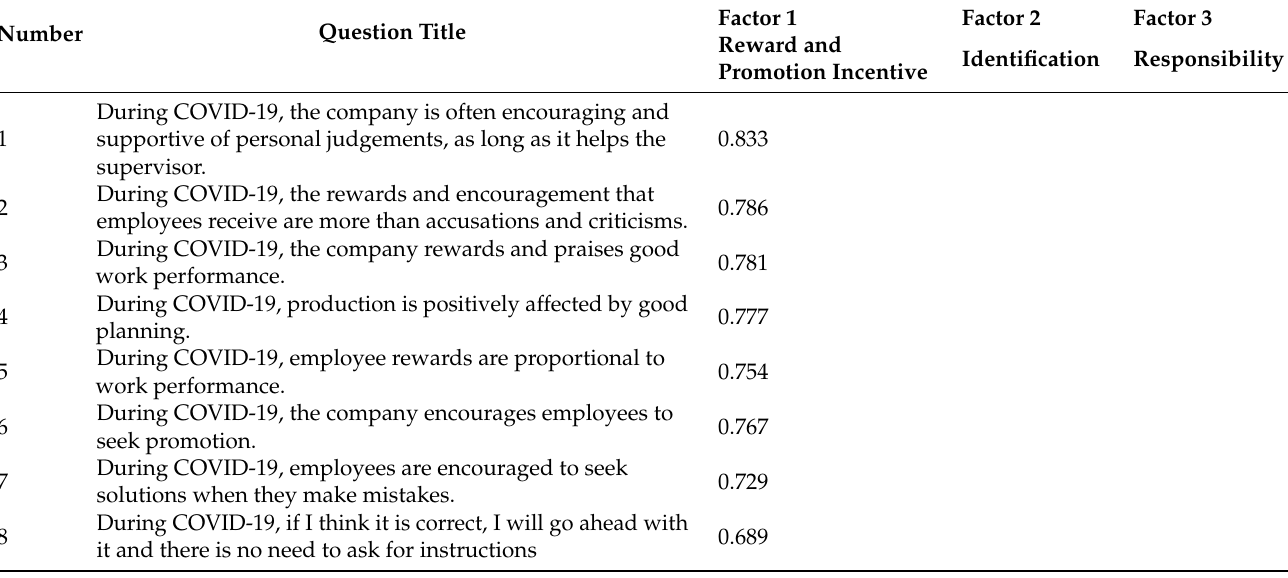
Table 1. Summary table of factor analysis of organizational climate